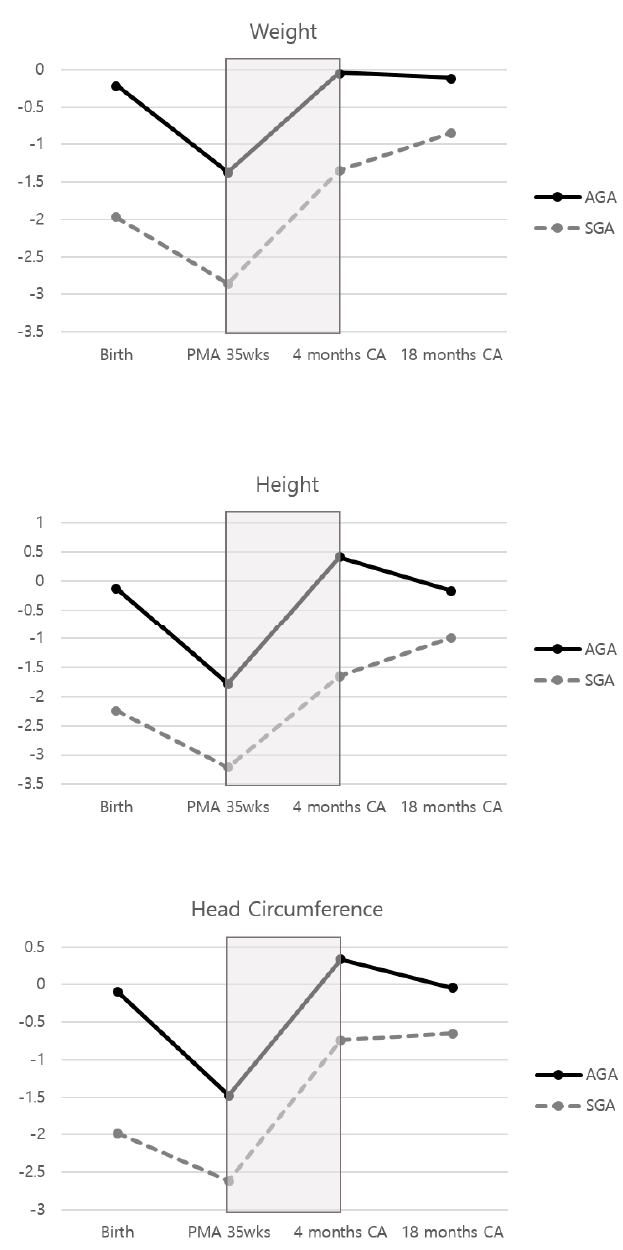
Figure 2. Infant size mean z-scores from birth to 18 months corrected age (CA). The mean z-score changes between postmenstrual ages 35 weeks and 18 months were not significantly different between small-for-gestational-age and appropriate-for-gestational-age infants (gray box).